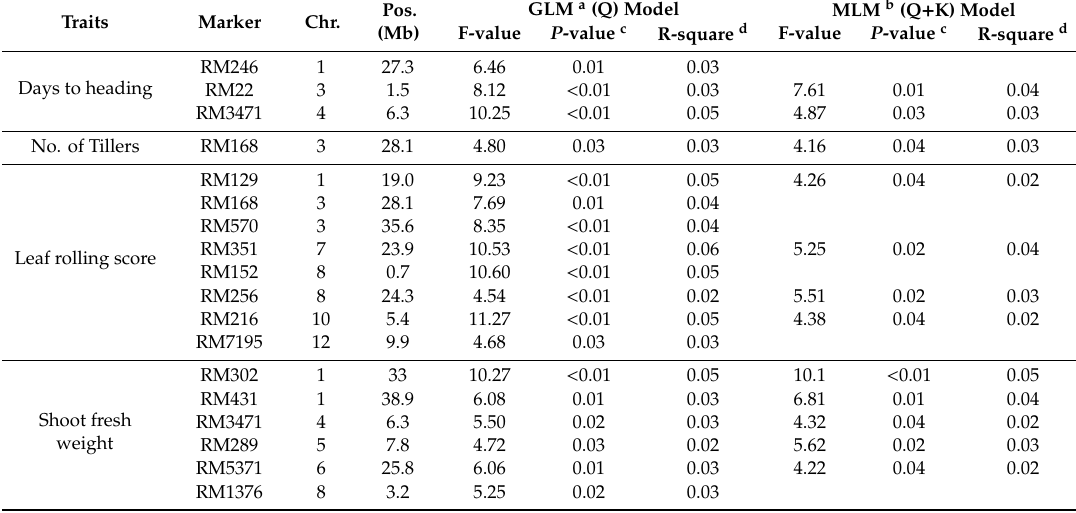
Table 6. Significant marker trait association in rice genotypes under drought stress using GLM (Q) and MLM (Q + K)